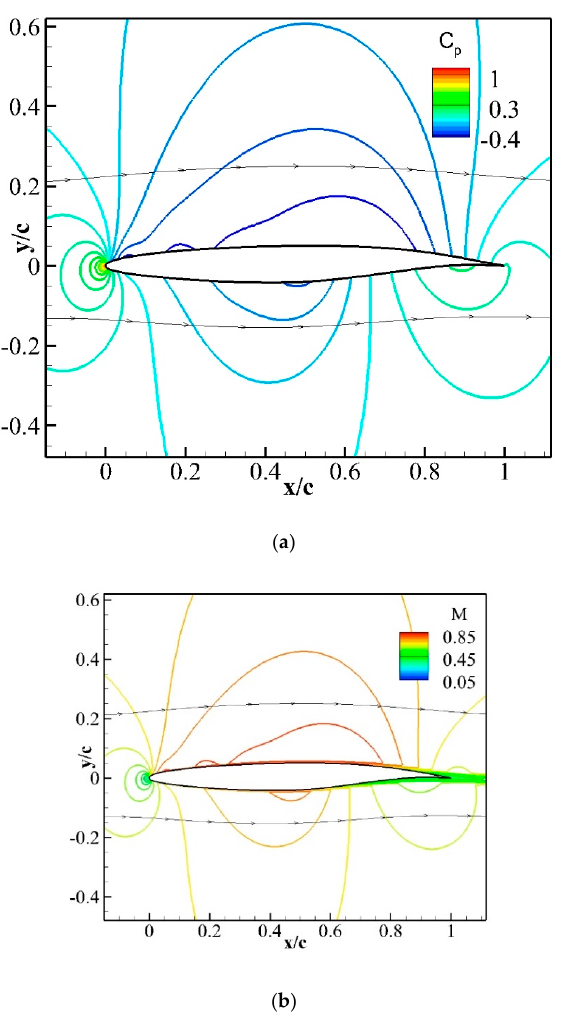
Figure 15. Computed ( a ) coefficient of pressure and ( b ) Mach contours for flow over the baseline airfoil at a zero angle of attack.